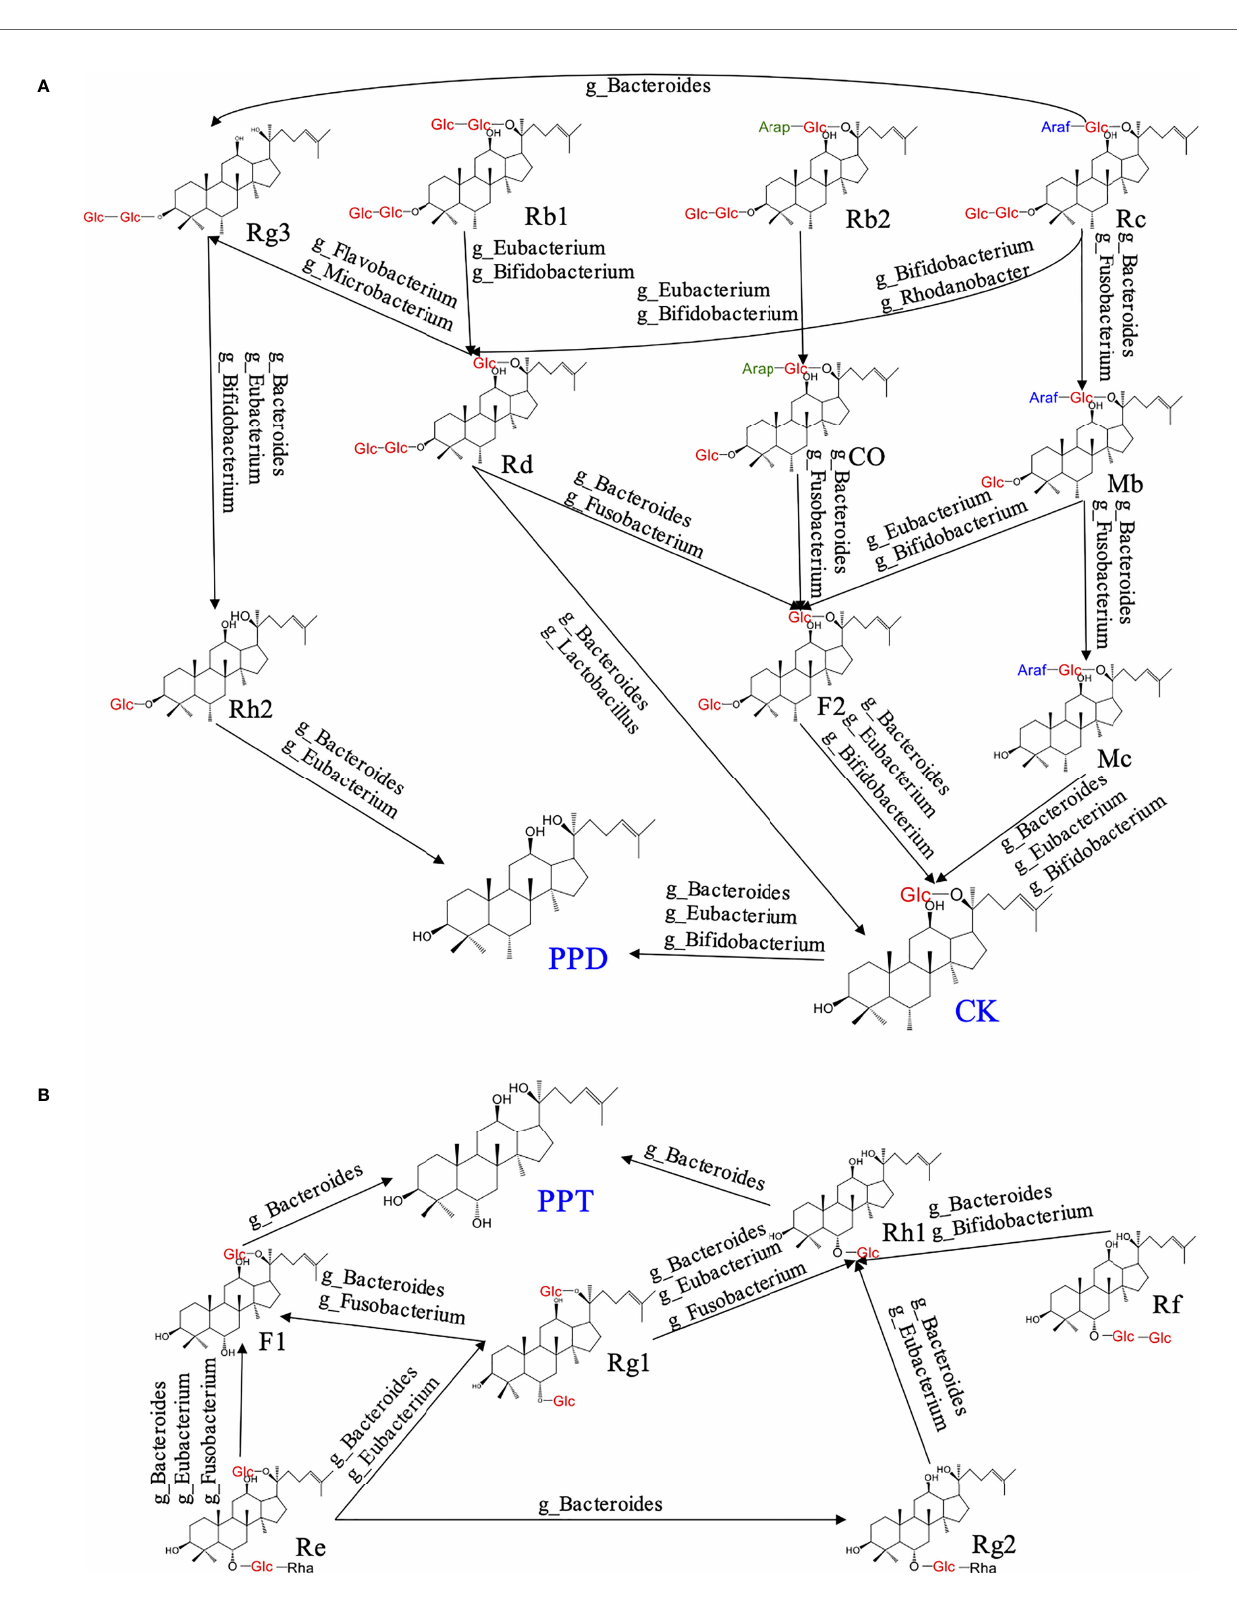
FIGURE 2 | The metabolism of ginsenosides under the action of gut